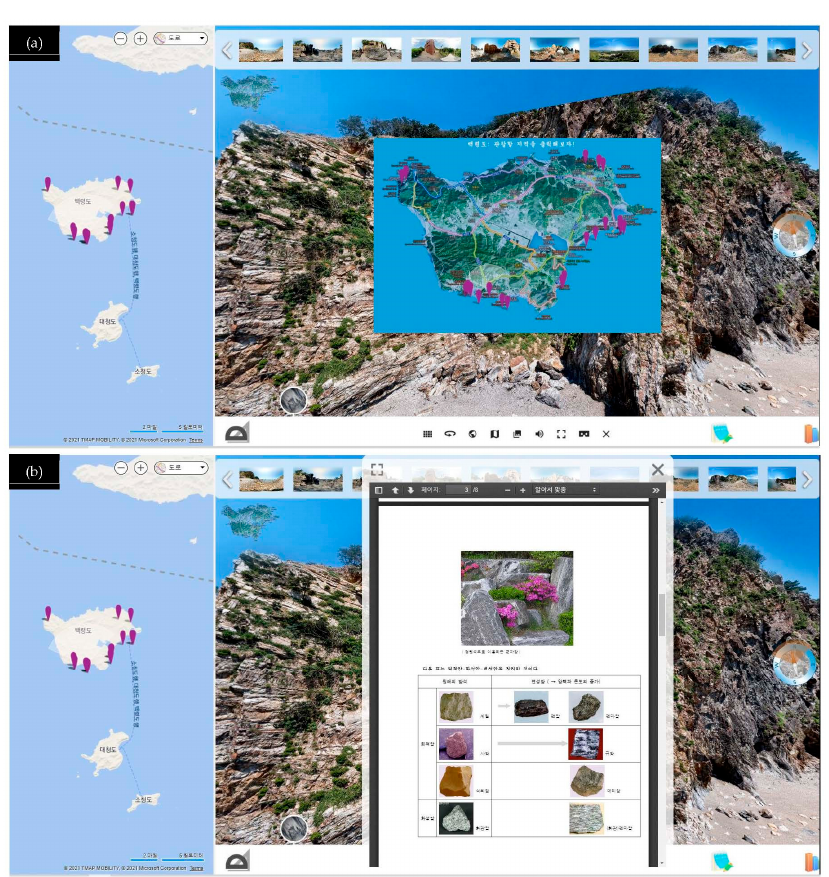
Figure 4. Main Screen of Virtual Field Trip (VFT) Program Developed in our study using KrPano. When clicking the “Show map” menu a map connected to Bing maps appears on the left for geographical information ( a ). The materials for the preparatory study pops up when clicking the notepad icon ( b ).